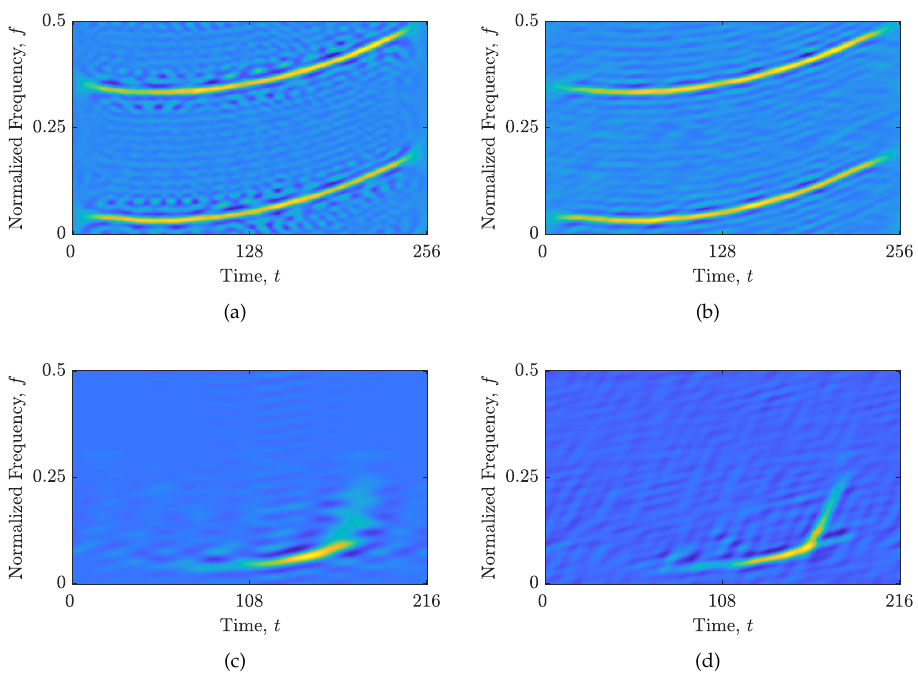
Figure 3. The obtained TFD from the filtered AF of: ( a ) the z SS with a full N (cid:48) τ × N (cid:48) ν area, Γ = 0, Υ = 1; ( b ) the z SS with the proposed CS-AF area, Γ = 0.06, Υ = 0.5; ( c ) the z RS with a full N (cid:48) τ × N (cid:48) ν area, Γ = 0, Υ = 1; ( d ) the z Γ = 0.15, Υ = RS with the proposed CS-AF area,